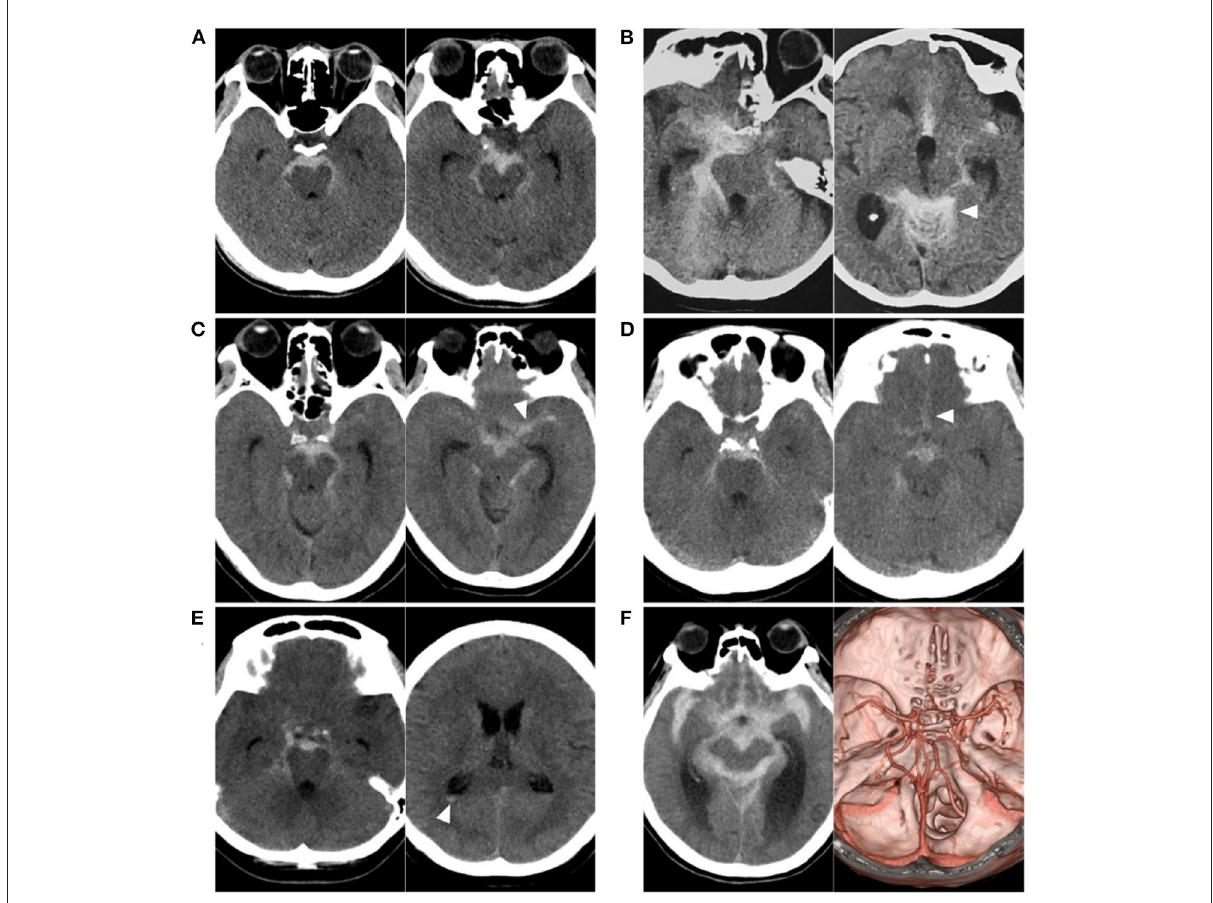
FIGURE1 Various SAH with negative angiography. (A) CT showing a PNSAH only with focal pre-pontine hemorrhage. (B) CT showing a PNSAH with involvement of quadrigeminal cistern (arrowhead). (C) CT showing a PNSAH extended to the basal part of the Sylvian fissure (arrowhead). (D) CT showing a PNSAH extended to the posterior part of the interhemispheric fissure (arrowhead). (E) CT showing a PNSAH with intraventricular sedimented blood (arrowhead). (F) Left: CT showing a diffuse non-PNSAH; Right: the intracranial aneurysm was not found on CTA; the drainage pattern of the deep vein around vein of Galen was normal. CT, computed tomography; CTA, computed tomography angiography; PNSAH, perimesencephalic non-aneurysmal subarachnoid hemorrhage; SAH, subarachnoid hemorrhage.